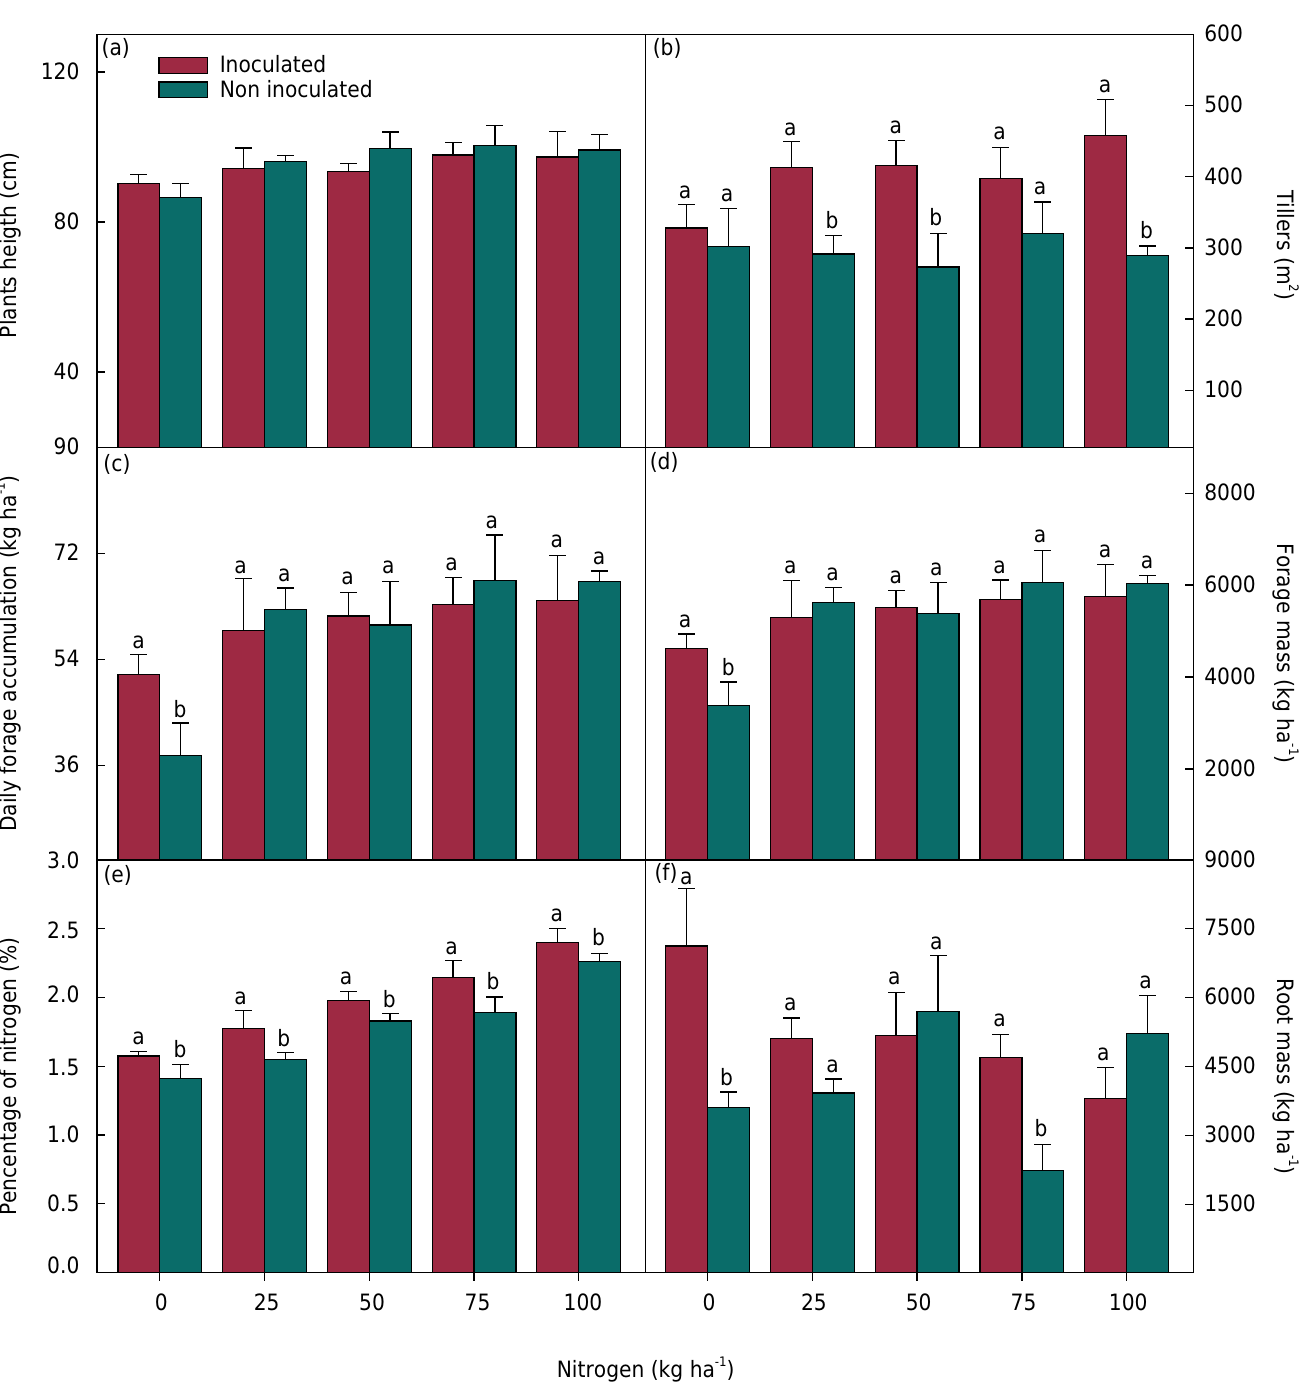
Figure 3. Plants height (a), number of tillers (b), daily forage accumulation (c), forage mass (d), percentage of nitrogen (e), and root mass (f) of Mombasa Grass in relation to inoculation with A. brasilense and nitrogen fertilization. Values followed by the same letter for the doses do not significantly differ by the Tukey test at 5